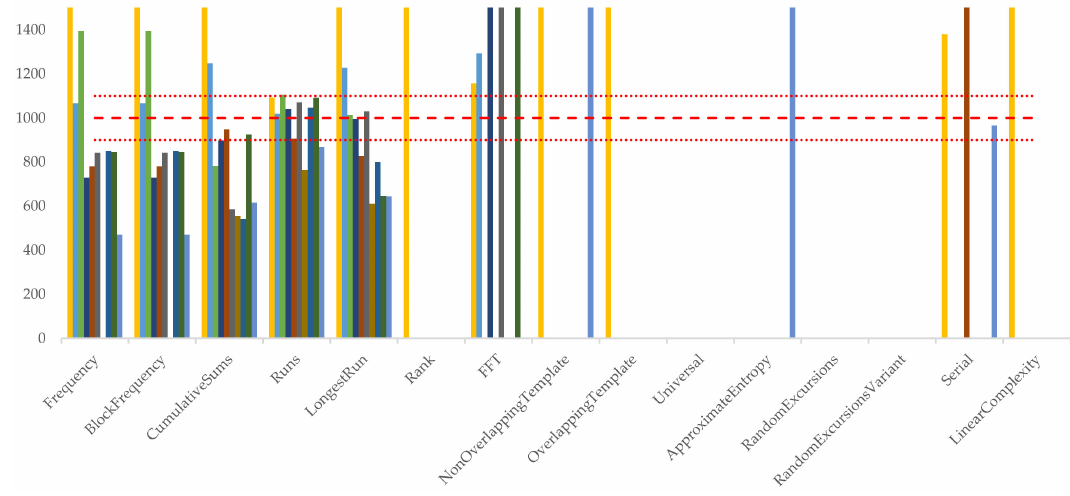
Figure 8. Graphical presentation of the NIST test